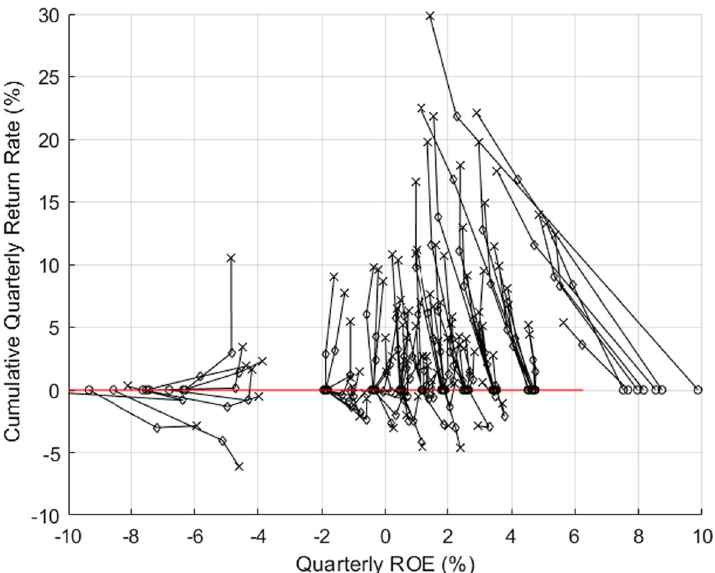
Fig. 27 Three‑view drawing: the relationship between ROE and cumulative quarterly return rates (circle, diamond, x‑mark: the data in the t, t